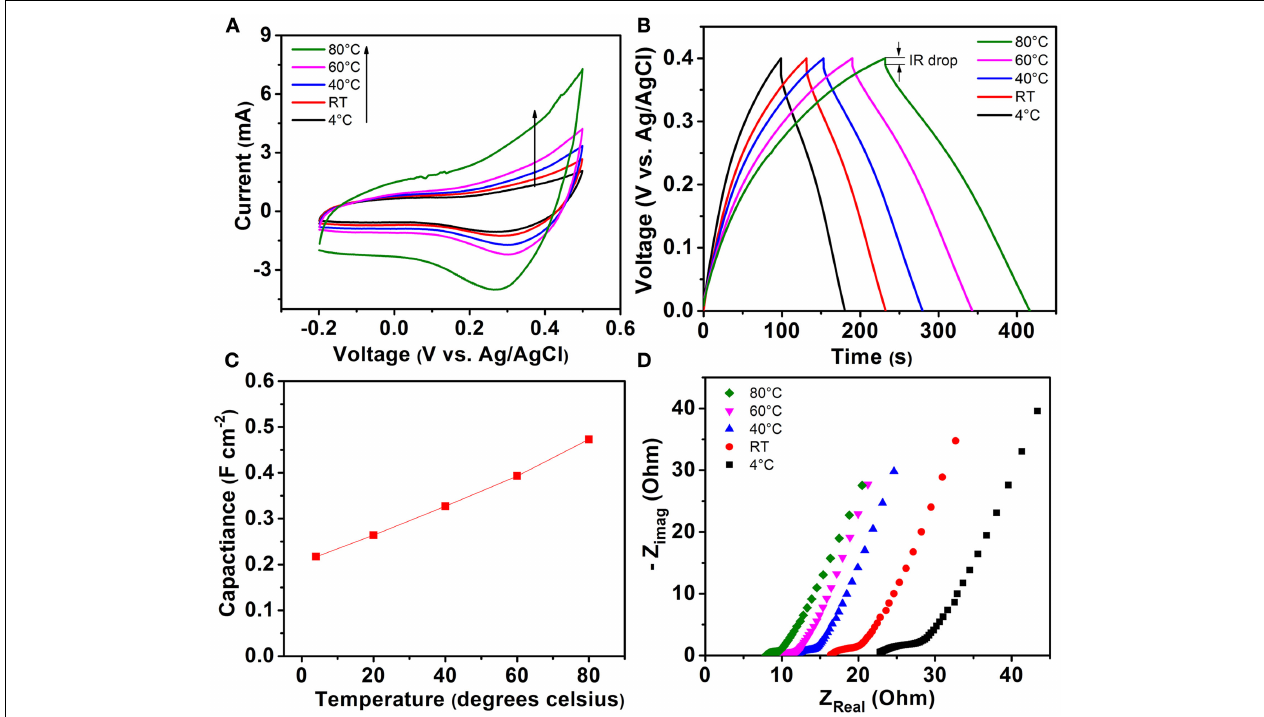
FIGURE 6 | (A) CV curves of Ni–Co–Mn oxide nanoneedle electrodes at a fixed scan rate of 10mVs (cid:0) 1 in 0.1M KOH electrolyte at temperatures of 4°C, RT, 40, 60, and 80°C. (B) Galvanostatic charge/discharge curves of Ni–Co–Mn oxide electrodes at a current density of 1mAcm (cid:0) 2 and temperatures of 4°C, RT, 40, 60, and 80°C in the voltage range between 0 and 0.4V vs. Ag/AgCl. (C) Areal capacitances of metal oxide electrodes calculated from charge/discharge curves in (B) at different temperatures at a constant current density of 1mAcm (cid:0) 2 . (D) Nyquist plot for the Ni–Co–Mn oxide nanoneedle electrodes recorded from 0.1Hz to 1MHz measured at different